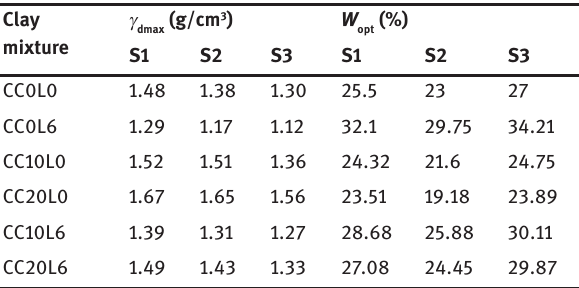
Table 6: Maximum dry unit weight g W of the clay opt